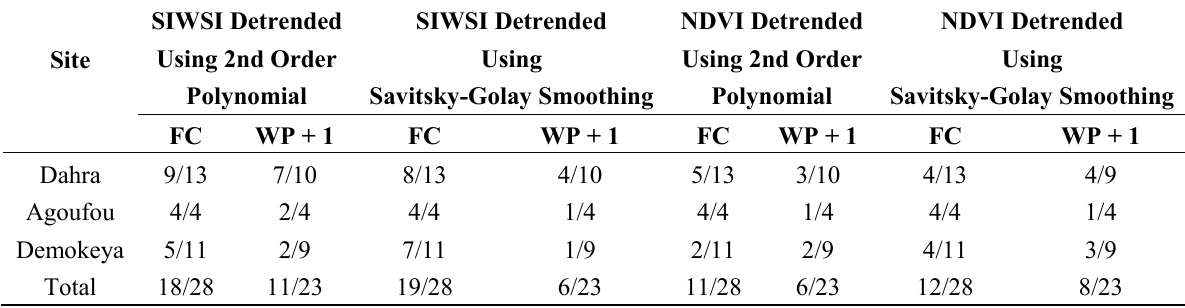
Table 7. Number of dry events, out of total number of dry events, where Shortwave Infrared Water Stress Index (SIWSI) anomalies are increasing, or Normalized Difference Vegetation Index (NDVI) anomalies are decreasing, significantly (p < 0.05) in comparison with number of days after Soil Moisture Content (SMC) drops below threshold. Wilting point ( WP) + 1 and Field capacity (FC) are both tested as thresholds. Anomalies are derived using both 2nd order polynomials and Savitsky-Golay